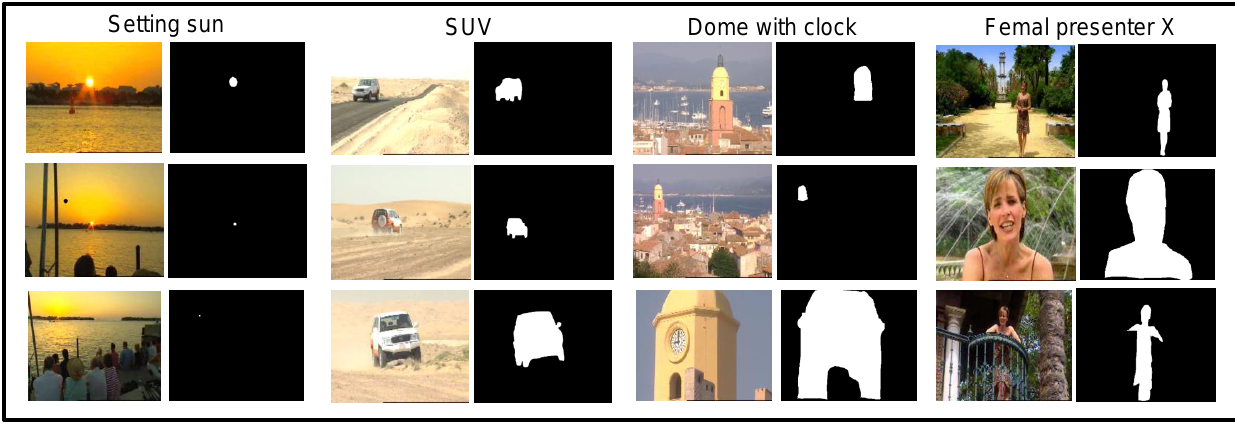
Figure 13. Object examples of the instance search